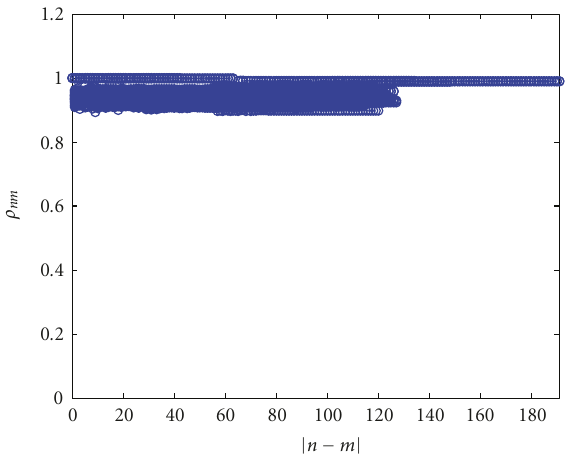
Figure 7: The RMSE for ETAM and LP-ETAM.